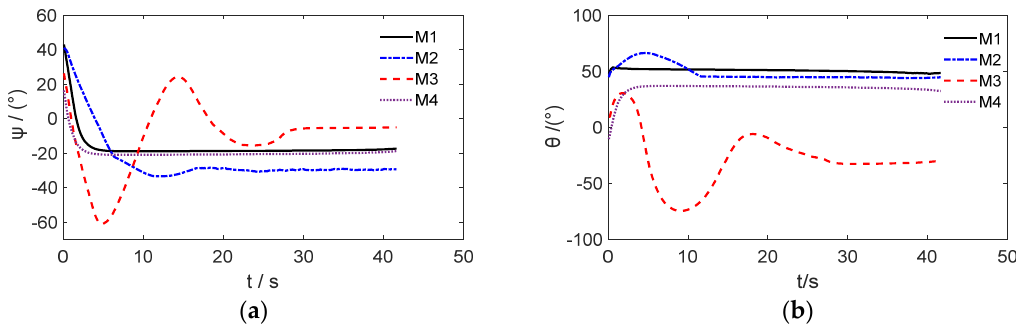
Figure 13. Velocity-inclination change curve of each follower missiles during cooperative attack on target 2 based on the MPC method: ( a ) Trajectory deflection curve; ( b ) Trajectory inclination curve.